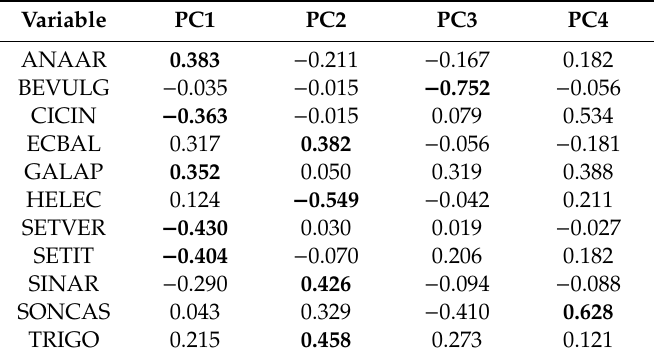
Table 5. Eigenvectors defining the linear combination of variables (11 major weeds) and principal components from the correlation matrix (PC5-PC11 were insignificant). The variables with the largest influence for each principal component are in bold.